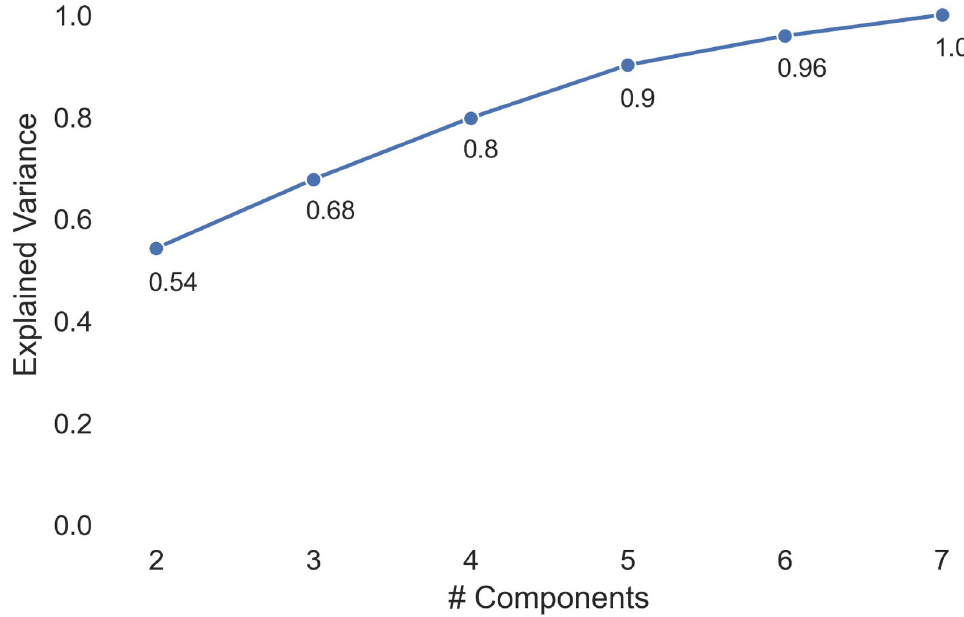
Fig 3. Plot of explained variance vs. number of principal components in PCA.